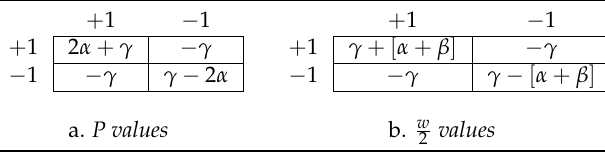
Table 8. A symmetric potential game’s P and w